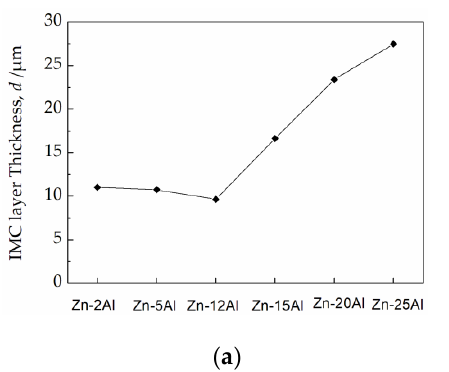
Figure 11. Changes of ( a ) IMC layer thickness and ( b ) bulk IMC ratio in Figure